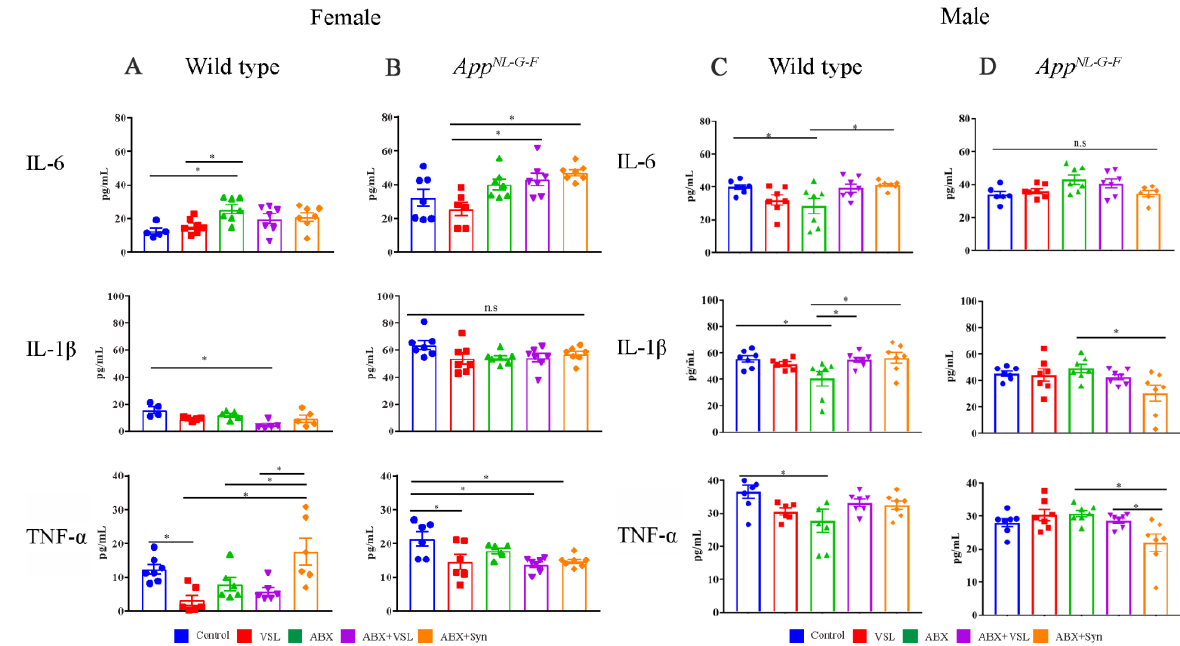
Figure 4. Effect of probiotic and antibiotics treatments on proinflammatory cytokines in female and male mice. Protein levels of interleukin-6 (IL-6), IL-1β, and tumor necrosis factor (TNF-α) were quantified from lysates prepared from parietal cortices of WT ( A ) and App NL-G-F ( B ) female mice and WT ( C ) and App NL-G-F ( D ) male mice treated with vehicle, VSL#3, antibiotics (ABX), antibiotics+VSL#3 (ABX + VSL), and antibiotics+VSL#3+prebiotic (ABX + Syn). Lysates were analyzed by enzyme-linked immunosorbent assay (ELISA). Data are presented as mean ± SEM. Significant differences were determined by one-way analysis of variance, * p < 0.05 ( n = 7).